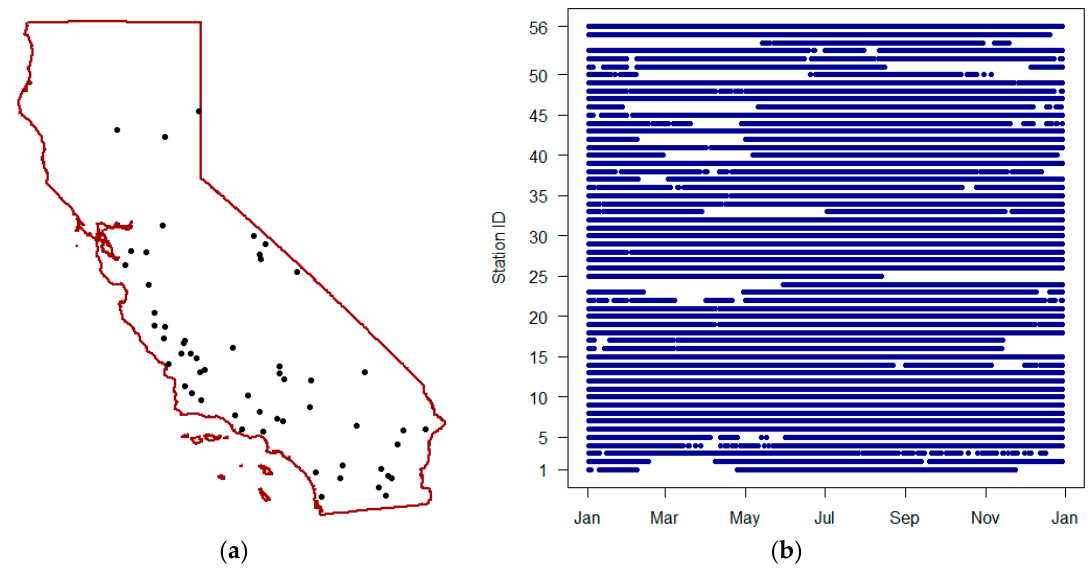
Figure 2. ( a ) Spatial distribution of the PBO_H2O soil moisture stations in the study area; and ( b ) soil moisture observations per station during the